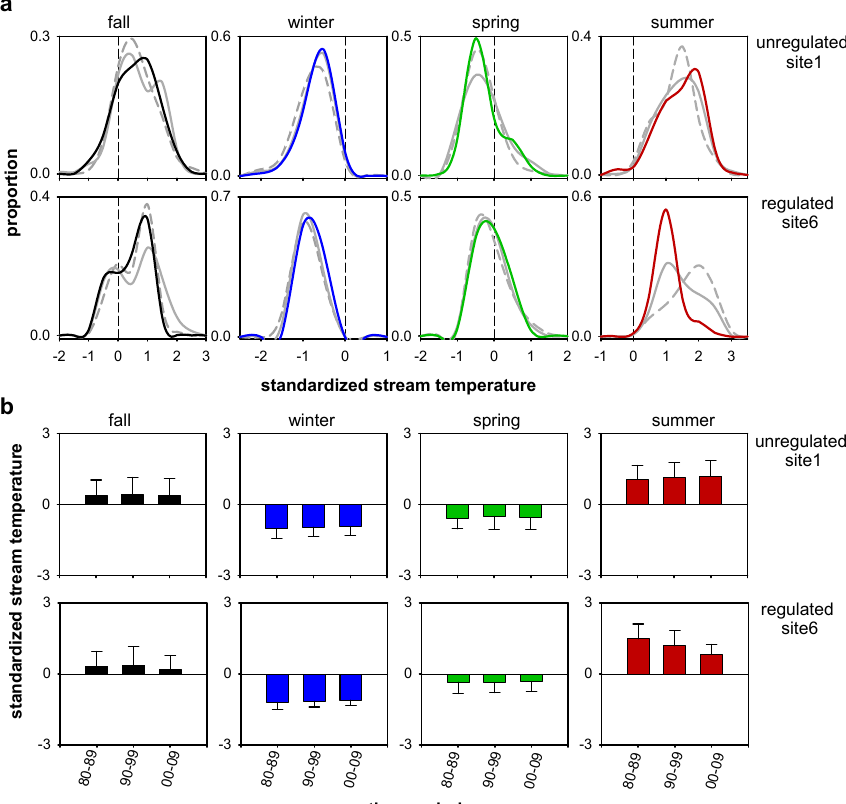
Figure 3. Examples of (a) density plots of standardized temperatures by decade (period 1980–1989 dashed line; period 1990–1999 grey line; period 2000–2009 solid color line) and season using time series of daily minimum in an unregulated (site1) and a regulated (site6) stream. In the lower panel (b) central tendency statistics (average ± SD) for each decade and season (winter – blue; spring – green; summer – red; fall – black) are also included. See results for all sites in Figs. S1 and